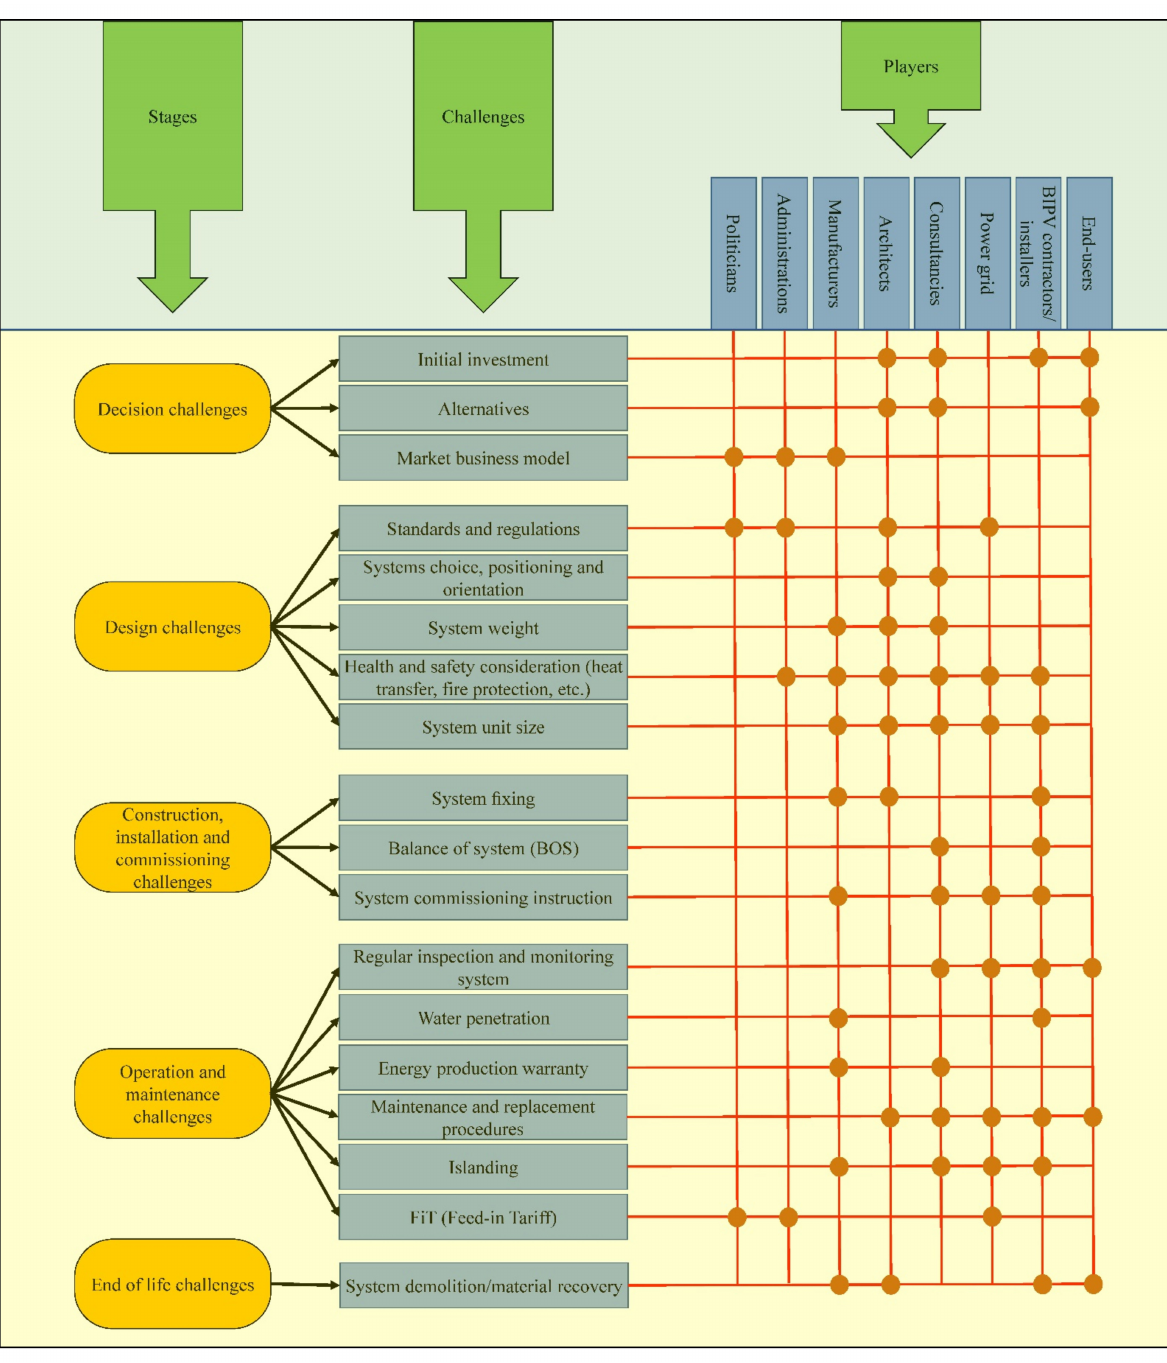
Figure 9. BIPV barrier classification and involved stakeholders who can contribute to the